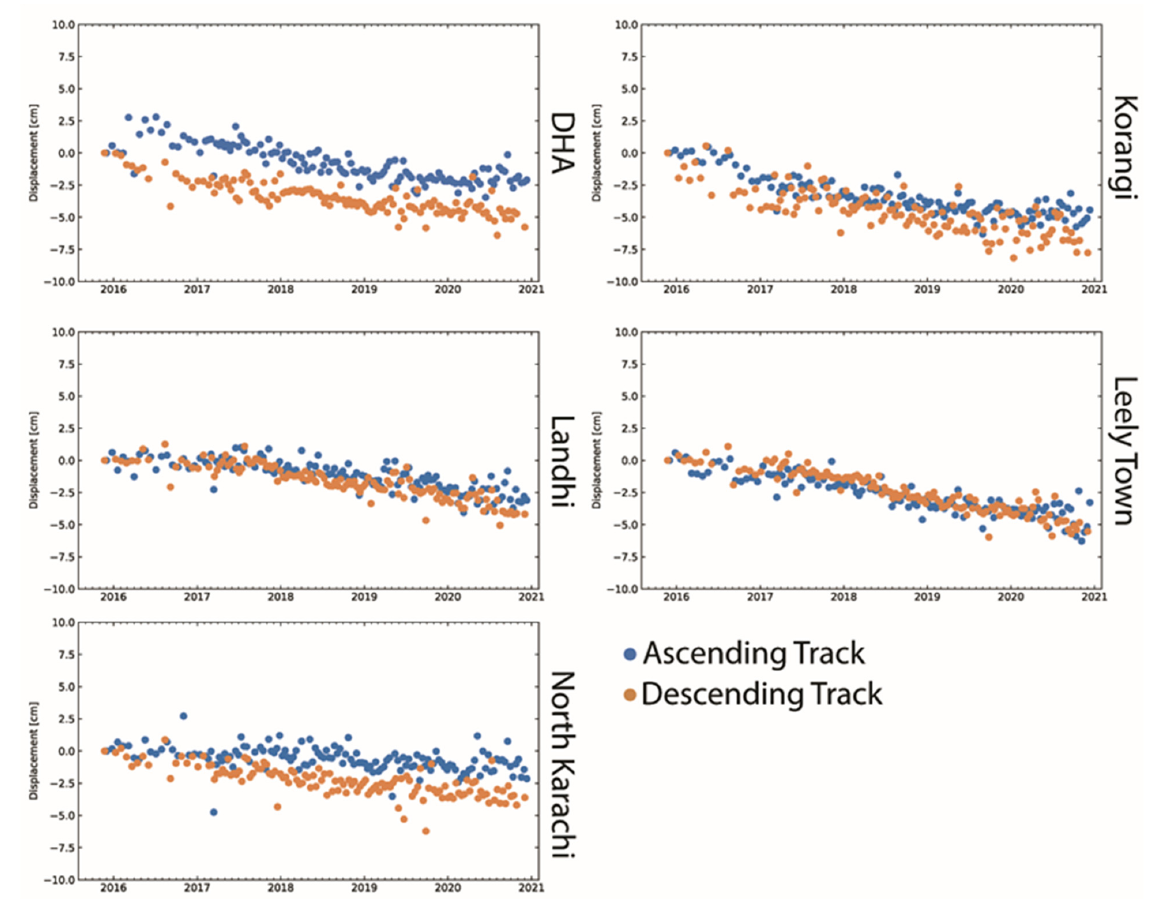
Figure 6. Timeseries plots of individual pixels representative of average displacement in key areas produced from the results of Sentinel-1 InSAR processing.